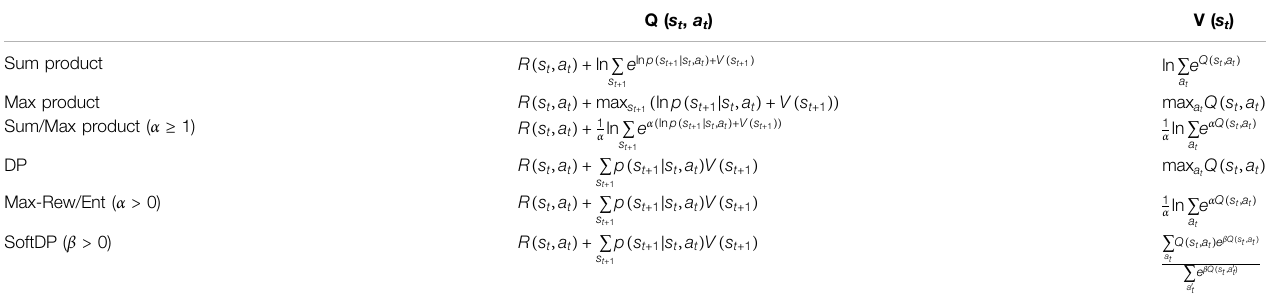
TABLE 1 | Summarized backup rules in log